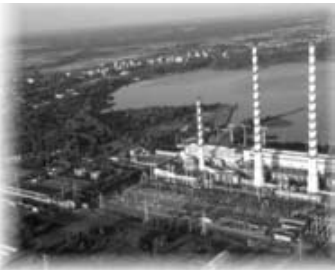
Fig. 6. Lithuanian Power Plant